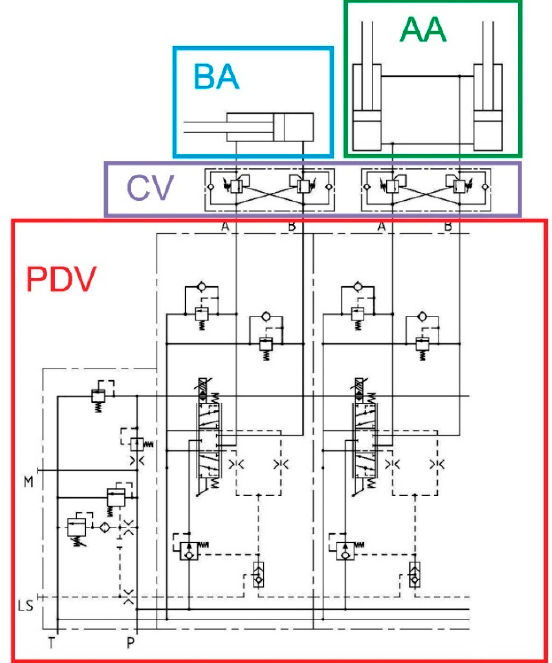
Figure 3. Diagram of boom and arm hydrostatic drive with counterbalance valves, where AA represents the hydraulic cylinders of the arm, BA represents the hydraulic cylinders of the boom, CV represents the counterbalance valves, and PDV represents the boom and arm section of the proportional directional valve with “load-sensing”